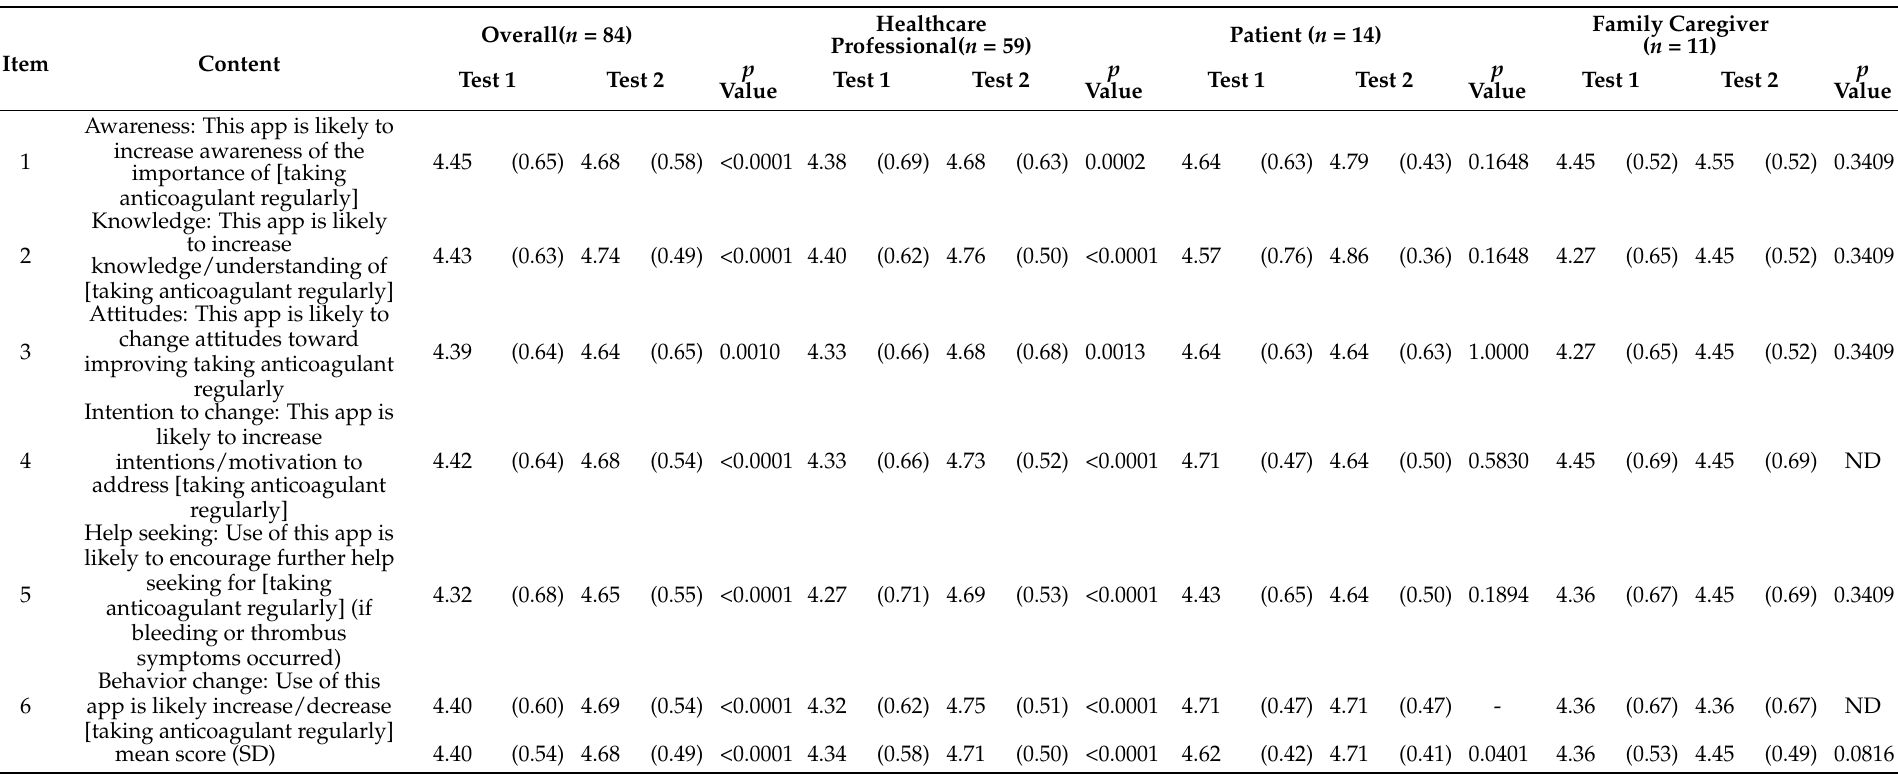
Table 3. App-specific MARS for perceived